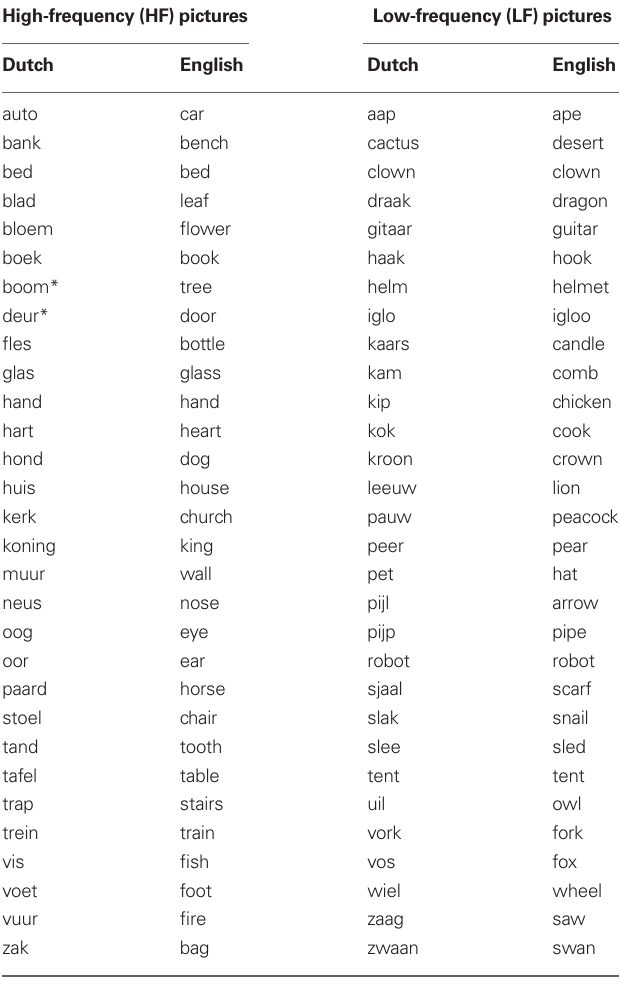
Pictures used as go stimuli in Experiment 1 are indicated with